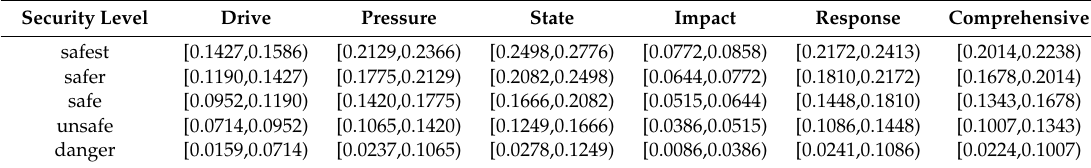
Table 6. Rare earth security performance level evaluation scale.